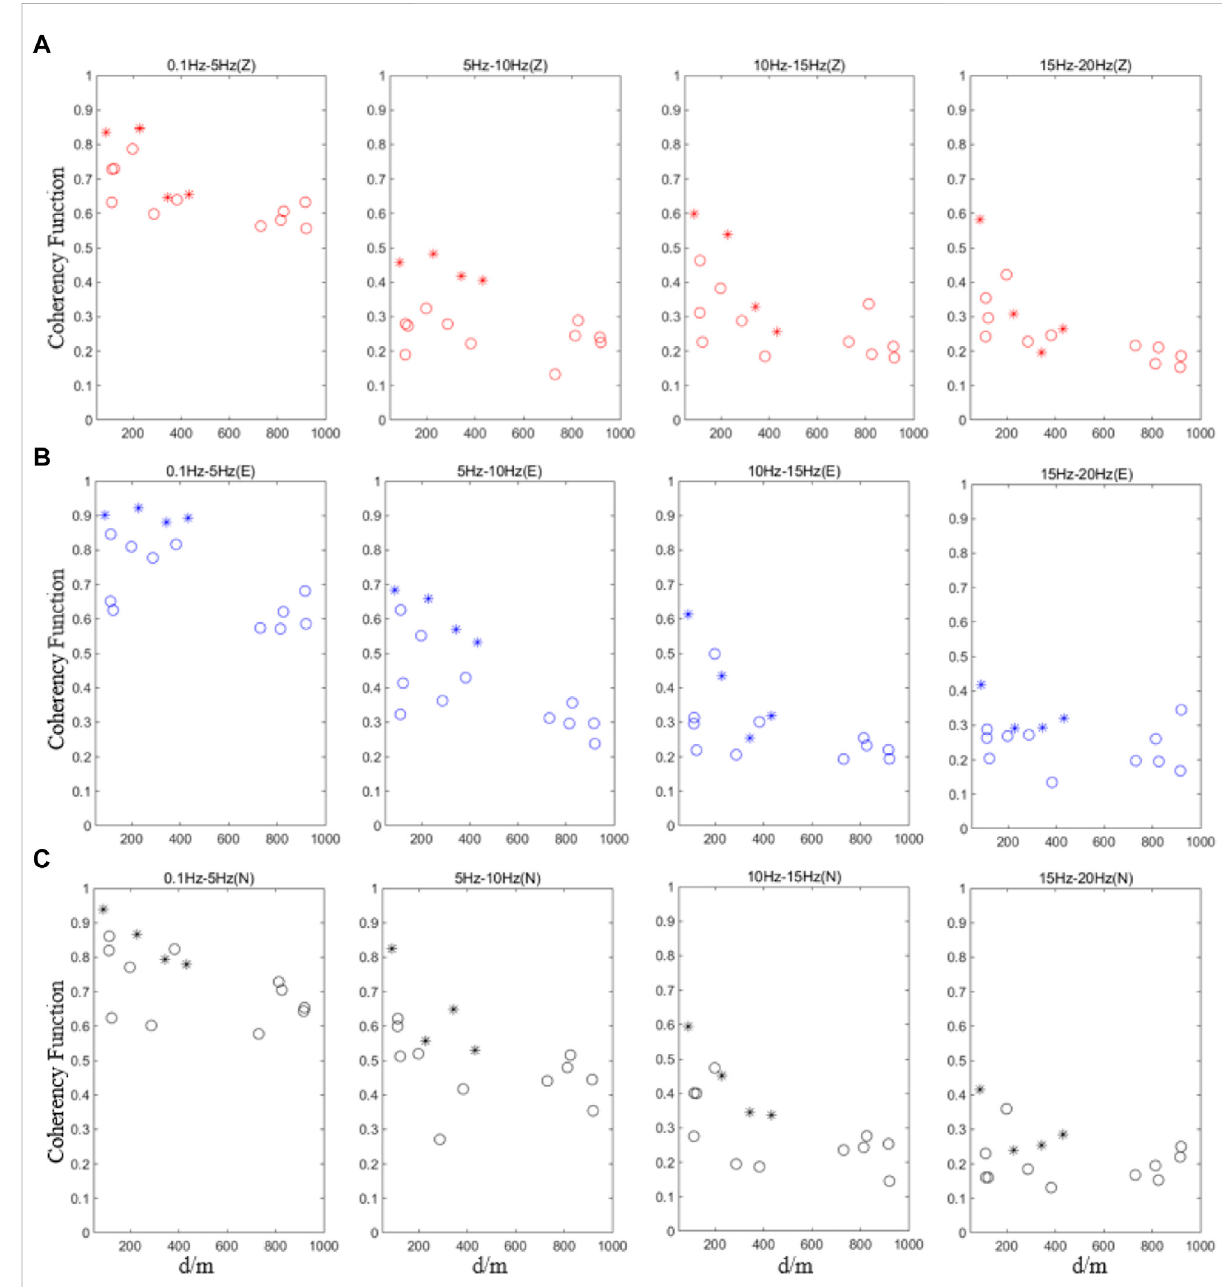
FIGURE 9 Variationinlagged coherencyasfunctions ofdistance (theLuxianearthquake).Theasterisk (*)representsthestationpairsofthesamesitetype, and the circle ( ○ ) represents the station pairs between other different site types. (A) UD component, (B) EW component, and (C) NS component.